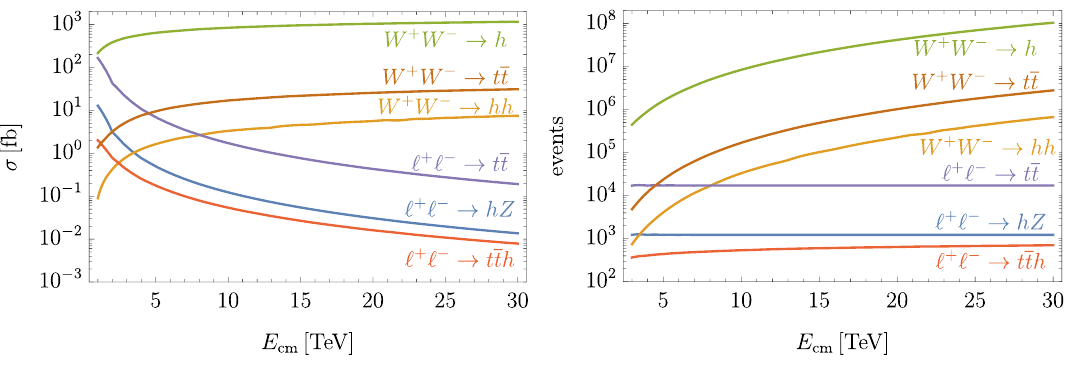
Figure 2 . Cross-sections and total number of expected events, using eq. (1.1), for selected SM